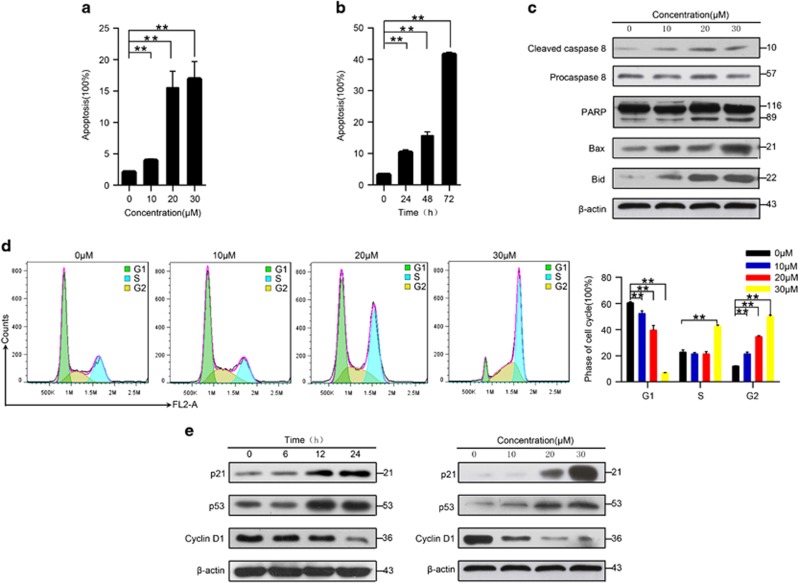
Cardamonin induces apoptosis and G2/M phase arrest in CNE-2 cells. (a) CNE-2 cells were cultured with indicated concentrations of cardamonin for 24 h, apoptosis was measured using Annexin V-FITC and PI staining method. **P<0.01, n=3. (b) CNE-2 cells were treated with 20 μM of cardamonin for different time, apoptosis was measured using Annexin V-FITC and PI staining method. **P<0.01, n=3. (c) Bid, Bax, Cleavage of caspase 8, caspase 8 and PARP were evaluated by western blot. (d) Cell cycle analysis after treatment with varying concentrations of cardamonin for 24 h. **P<0.01. (e) The protein expression of p53, p21 and Cyclin D1 was evaluated by western blotting after treatment with cardamonin